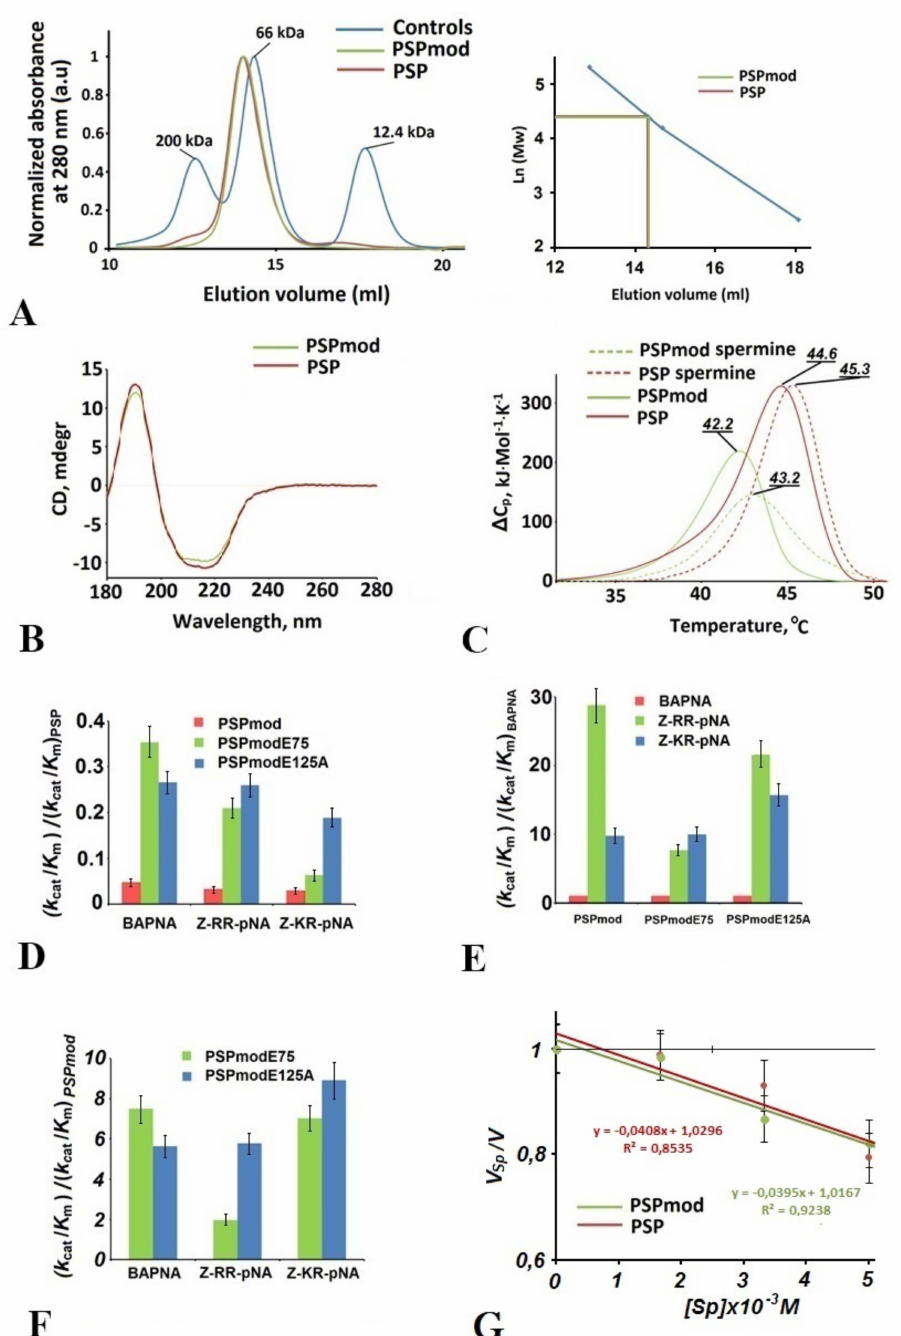
Figure 1. Comparative analysis of physicochemical features and enzymatic activity of PSPmod. ( A ) SEC was performed on the Superdex 200 10/300 GL column. Proteins (2 mg/mL) were eluted in 20 mM Tris-HCl (pH 7.8) and 100 mM NaCl buffer; ( B ) CD spectra normalized to the optical density value (0.5 at 205 nm). Absorption spectra were measured simultaneously with CD. The means of 3 measurements are presented; ( C ) temperature dependence of the excess heat capacity of denaturation ( ∆ Cp) measured by DSC for PSP and PSPmod in the presence and absence of spermine. In all cases, 2.0 mg/mL of protein was dissolved in 25 mM Na-phosphate buffer (pH 7.8) supplemented with 2 mM spermine, when indicated. Temperatures of melting curve maxima (Tmax) are shown at the top of the peaks; ( D – F ) kinetic parameters of hydrolysis (kcat/Km) normalized as indicated in the Y -axis legend. The corresponding parameters for wild-type PSP ( D ) and PSPmod ( F ) toward the indicated substrates are equal to 1 and not shown; ( G ) the effect of spermine on the initial rates of hydrolysis of BAPNA by PSP and